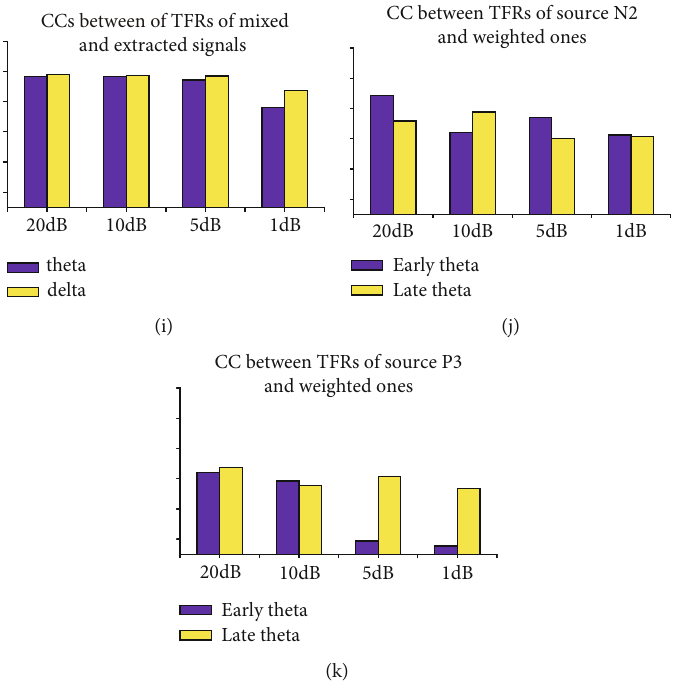
Figure 5: (a – i) The correlation coe ffi cients (CCs) between any two waveforms/topographies/time-frequency representations (TFRs) of the source, mixed, and proposed method extracted N2 (theta)/P3 (delta) for the synthetic datasets with di ff erent levels of SNR (i.e., 20dB, 10dB, 5dB, and 1 dB), respectively. (j, k) The CCs between the weighted TFR of source N2/P3 and early/late theta oscillations (using TFA-PCA method),